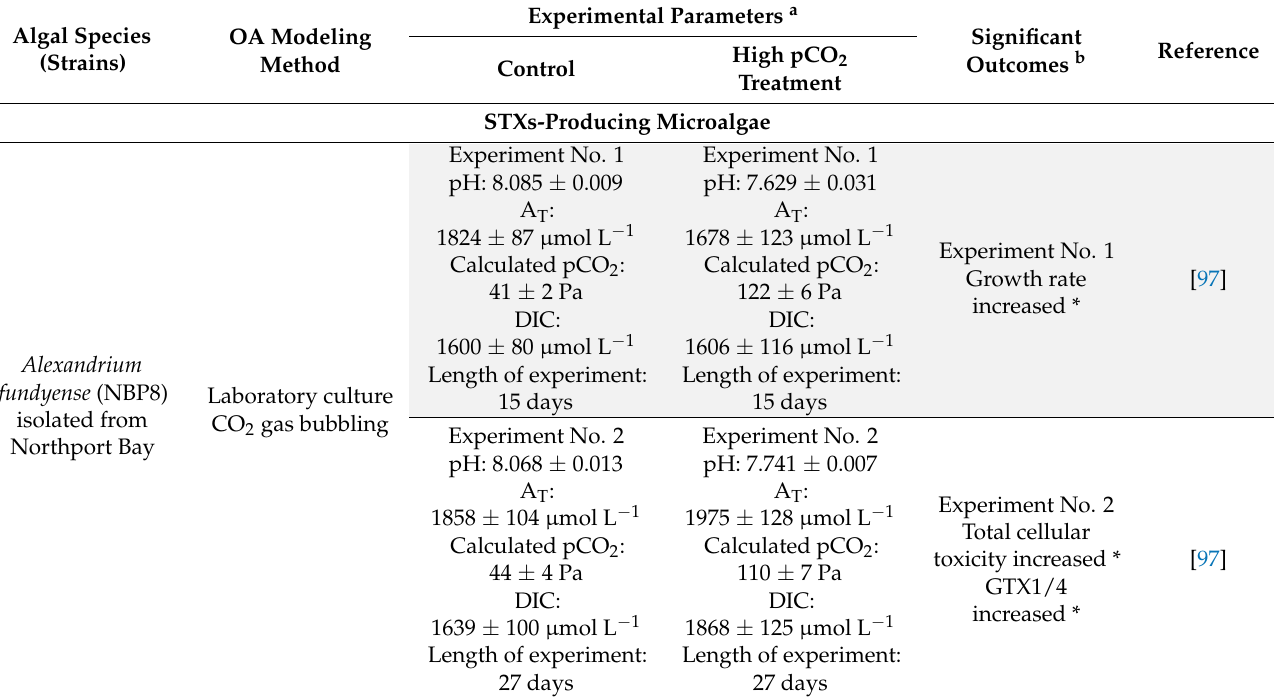
Table 1. Summary of reviewed studies on the effects of OA on toxigenic